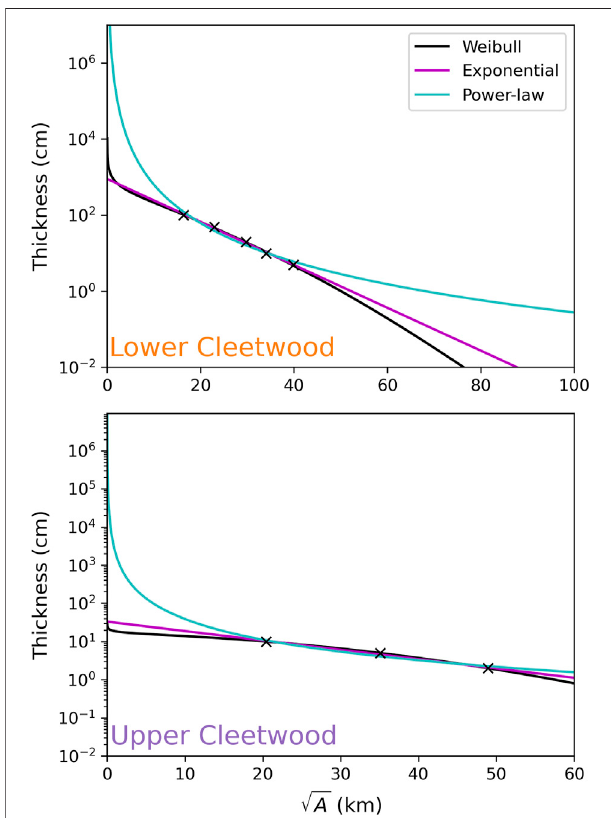
FIGURE 8 | (A-C) Semi-log plots of the thickness of a Phase deposit as a function of the square root of the isopach area and exponential, power-law, and Weibull best fi t deposit thinning trends for Llao Rock, lower Cleetwood, and upper Cleetwood, respectively. See Table 1 for fi tting parameters, Pearson correlation coef fi cients ( r 2 ), and erupted volumes